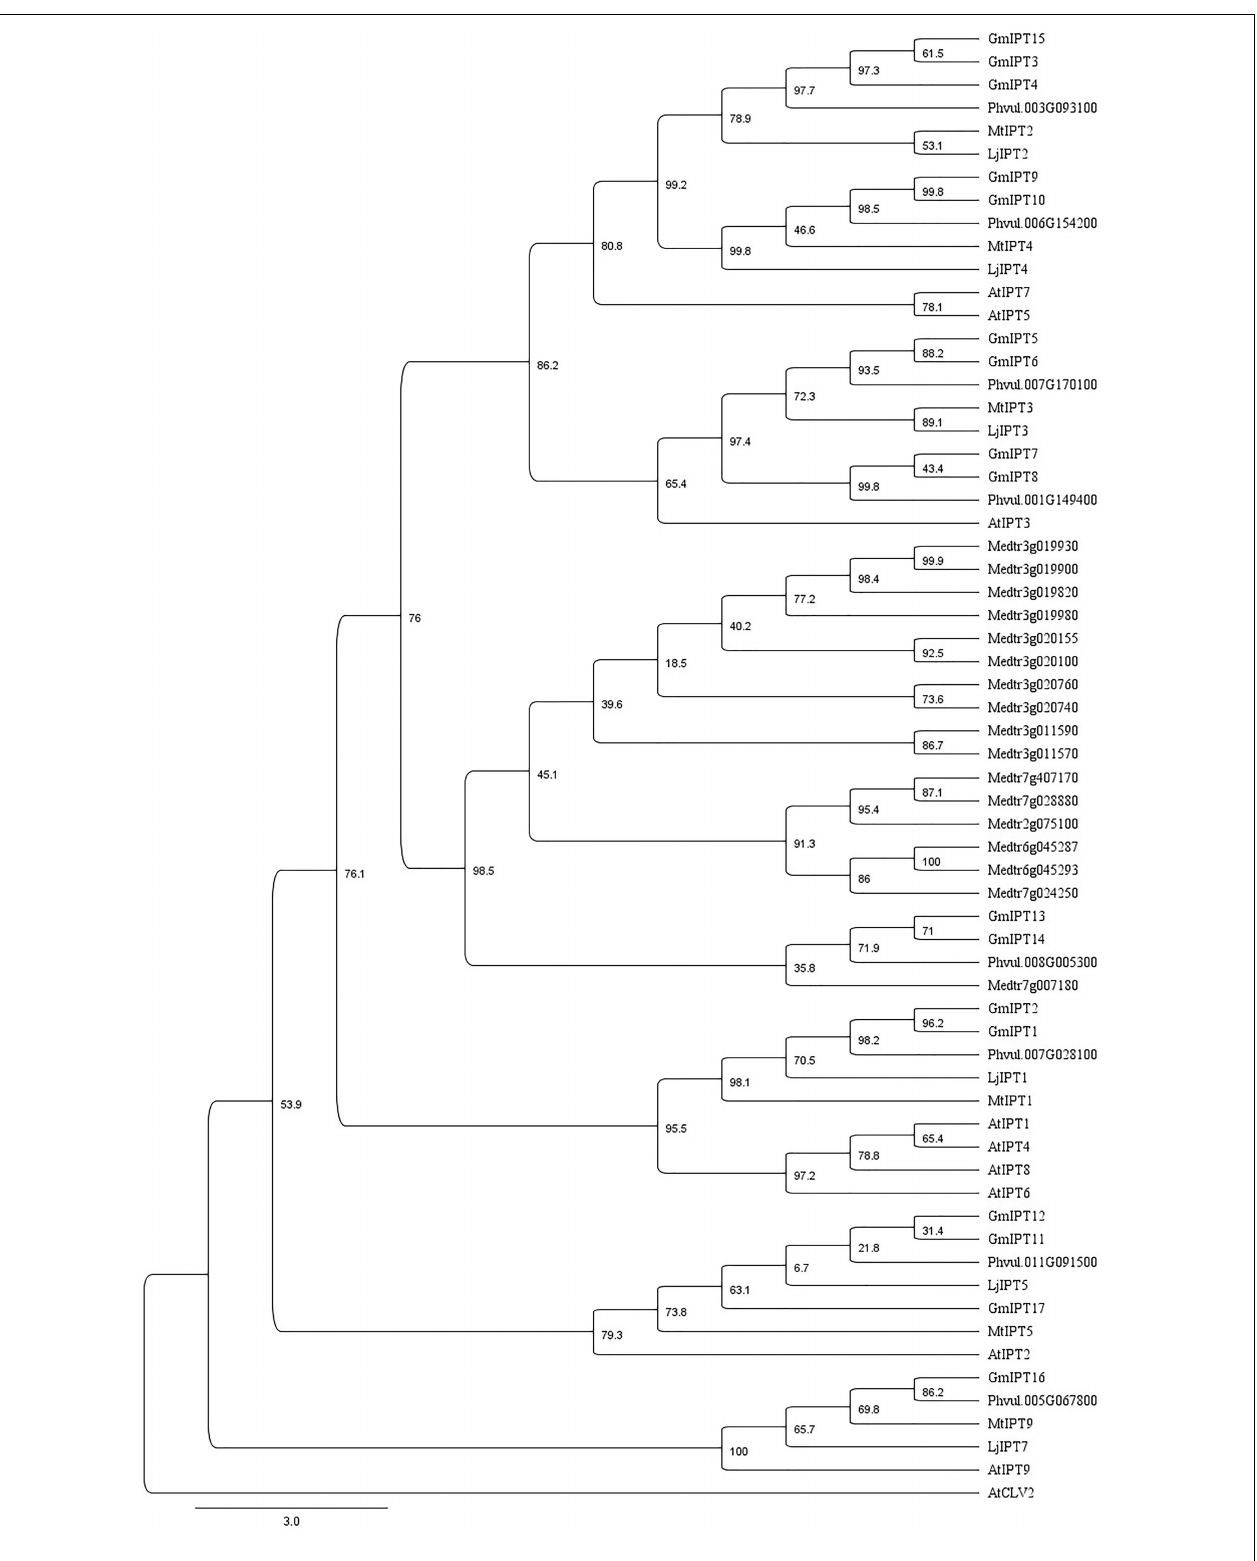
FIGURE 2 | Characterization of IPT orthologs. Phylogenetic tree generated using a multiple sequence alignment of homologous amino acid sequences with 75% of the gap regions removed showing similarity between IPT orthologs of soybean, L. japonicus , M. truncatula , common bean ( P. vulgaris ) and A. thaliana including AtCLV2 as an outgroup. The phylogenetic tree is shown with bootstrap confidence values as percentages from 1,000 bootstrap replications.